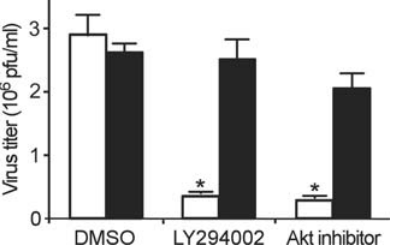
Figure 1. PI3K is important for early step(s) during ZEBOV infection. Vero-E6 cells were incubated with LY294002 (50 m M) or Akt inhibitor (10 m M) for 2 h in the presence of virus. Unbound virus and drug was then removed and cells were cultivated. After 10 d, cells were fixed in formalin and stained with crystal violet; plaques were then counted. Effect of the drugs on VSV (Indiana strain) infection was also tested similarly, except that plaques were counted 2 d after inoculation of cells. Open bars, ZEBOV; solid bars, VSV (* p ,